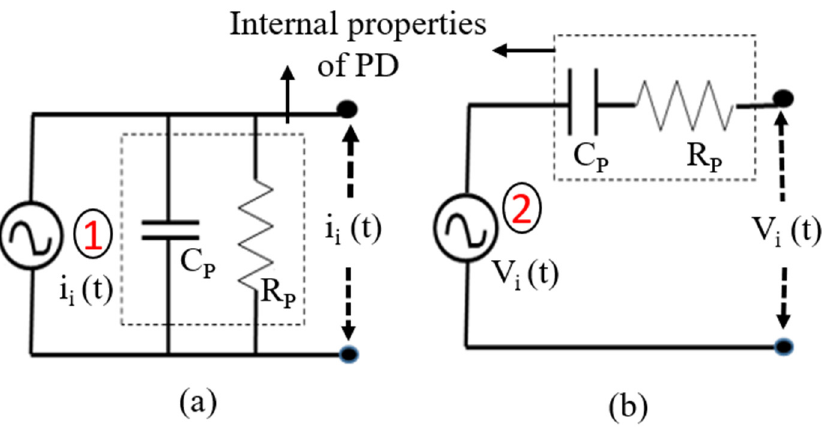
Figure 2. A vibrating PD circuit model ( a ). Current source and ( b ). Voltage source.